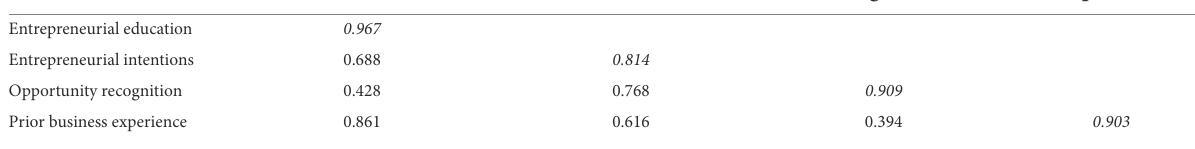
TABLE 4 Discriminant validity (latent variable correlation and square root of